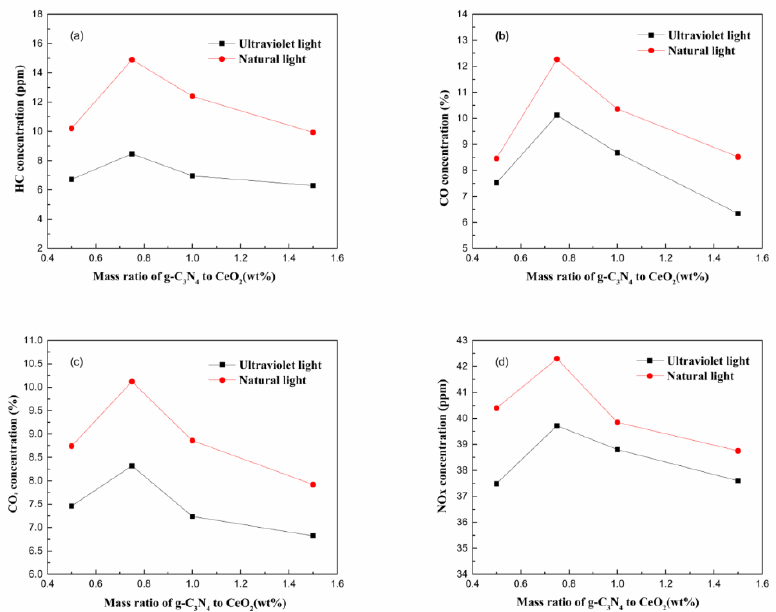
Figure 3. The purification effective change pattern at different g-C 3 N 4 to CeO 2 mass ratios for ( a ) HC, ( b ) CO, ( c ) CO 2 , and ( d ) NO X.